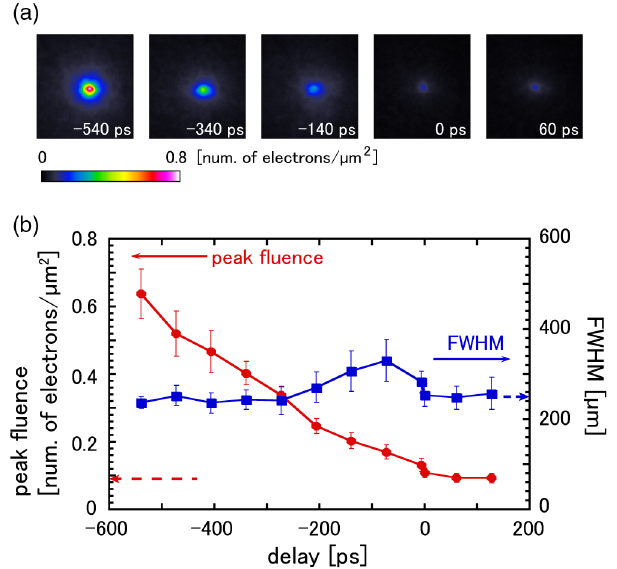
FIG. 3. (a) Images of the electron sources at time delays of − 540 , − 340 , − 140 , 0, and 60 ps. (b) Dependence of electron beam intensity on time delay. Error bars represent standard deviations. Dashed arrows show the results obtained by irradi- ation with the CPA1 pulse alone.